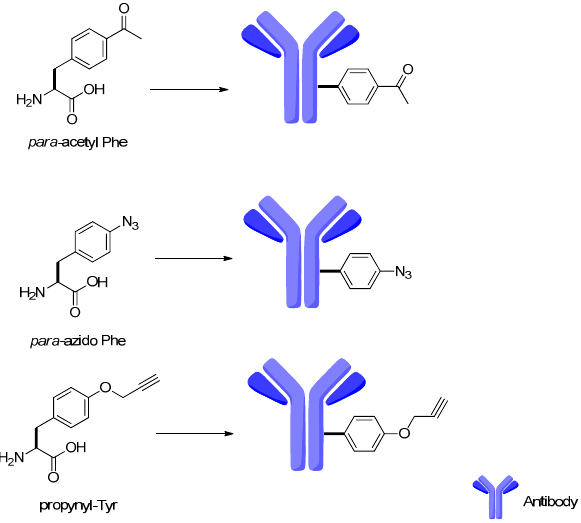
Figure 17. The commonly employed unnatural amino acids in the antibodies: para -acetyl Phe, para -azido Phe and propynyl-Tyr.